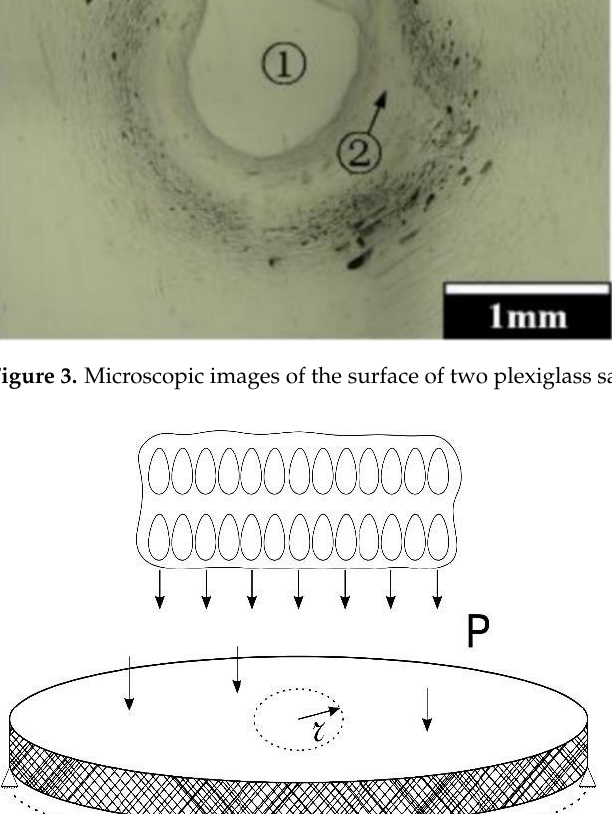
Figure 3. Microscopic images of the surface of two plexiglass samples after jet impact.